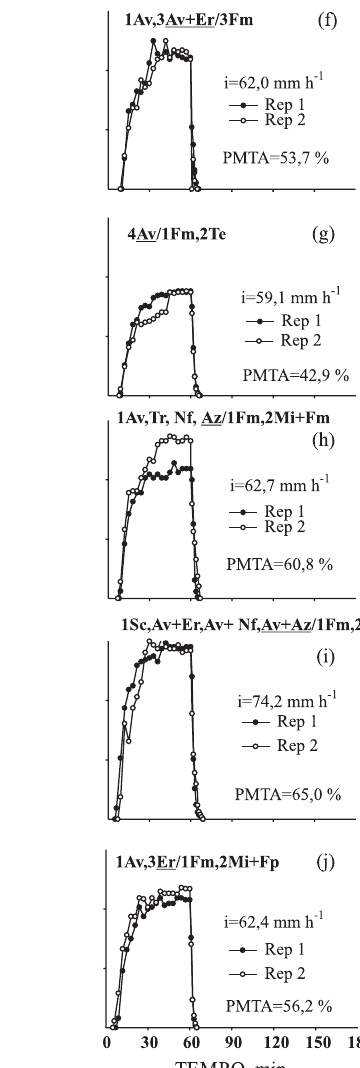
Figura 1. Taxas instantâneas de descarga da enxurrada (TDE) no primeiro (T1: solo não mobilizado, raízes mortas, crosta natural, 100 % coberto - figuras (a) a (e), à esquerda) e no segundo (T2: solo não imobilizado, raízes mortas, crosta rompida, 18 % coberto – figuras (f) a (j), à direita) teste de erosão com chuva simulada, nas sequências culturais estudadas (Av: aveia-preta, Er: ervilhaca, Fm: feijão-miúdo, Te: teosinto, Tr: trevo-calypso, Nf: nabo forrageiro, Az: azevém, Mi: milho, Sc: sem cultivo, Mt: milheto e Fp: feijão-de-porco). Valores individuais para cada repetição dos tratamentos (Rep 1 e Rep